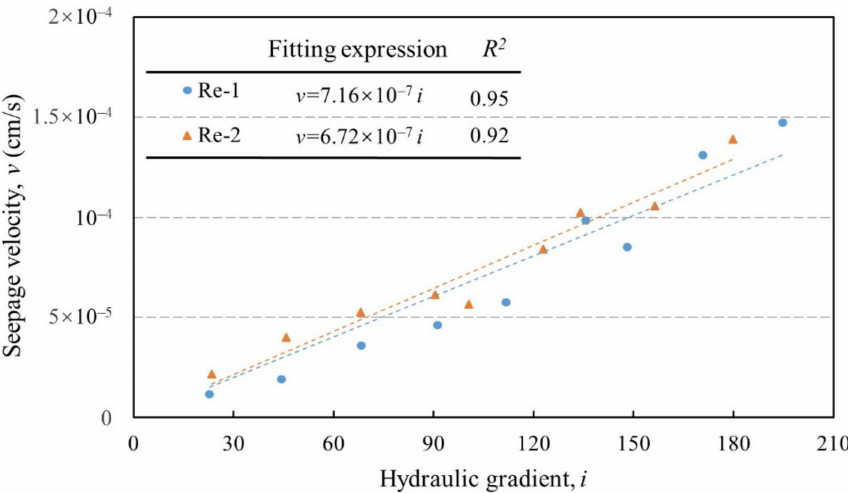
Figure 8. v–i relationship during the repeatability